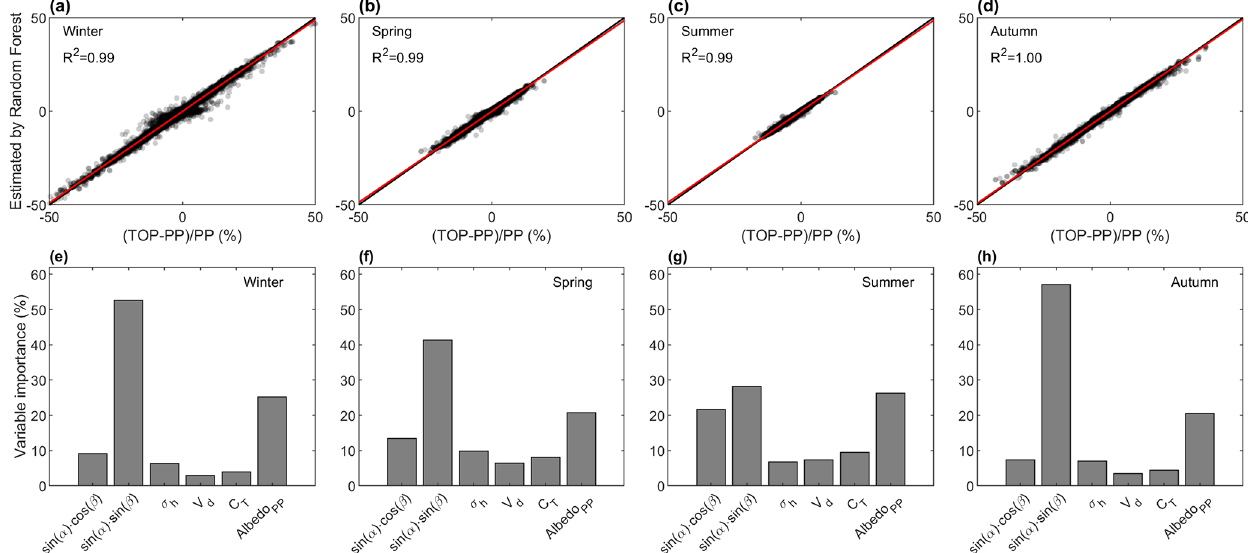
Figure 5. The performance of the random forest modeling in predicting the relative difference in land surface albedo between TOP and PP for four seasons (a–d) . The relative importance of different factors in predicting the differences in surface albedo between TOP and PP for four seasons (e–h) . R 2 is the coefficient of determination and the different factors are described in the text.